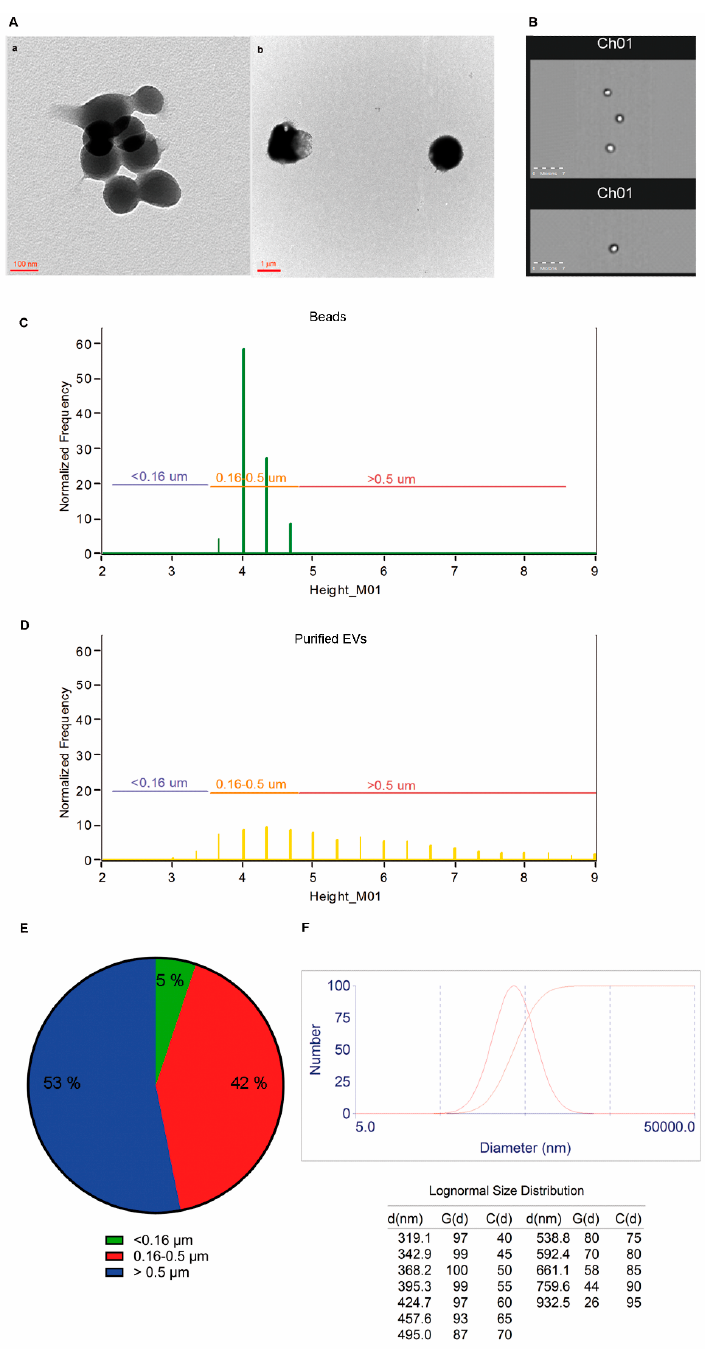
Figure 2. LCD+/Phalloidin- EVs features. ( A ). Transmission electron microscopy micrographs show EVs purified from whole blood samples (scale bar a. 100 nm; b. 1 µ m). ( B ). Sorted EVs preparations were analyzed by an ImageStream X Mk II Imaging Flow Cytometer equipped with a 60X lens and some captured brightfield images (Channel 1) were shown. ( C ). MegaMix-Plus SSC beads were acquired by ImageStream X Mk II and shown as a graph representing their diameters (calculated as height signals of the brightfield channel–M01). Three gates were established on this graph: a region encompassing all the events smaller than 160 nm (<0.16 µ m), a gate including all the events displaying diameters in the range 160–500 nm (0.16–0.5 µ m), and a region enclosing the events bigger than 500 nm (>0.5 µ m). ( D ). These three gates were applied to the analysis of the LCD+/Phalloidin- EVs samples, previously separated by activated-cell sorting and then acquired by ImageStream X Mk II, using the same settings used for the acquisition of the beads. ( E ). Percentages of the different EVs diameters were reported as a pie chart ( n = 3). ( F ). Sorted EVs preparations were analyzed by dynamic light scattering (DLS). G(d) refers to the relevant distribution information data and C(d) to the relevant cumulants data related to the measured autocorrelation function. Data are representative of at least three separate